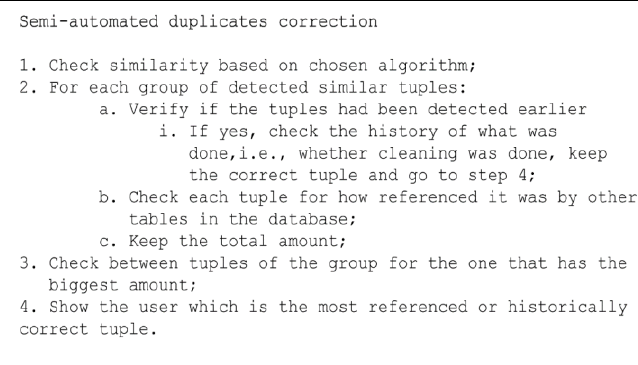
Figure 2: Semi-automated duplicates correction